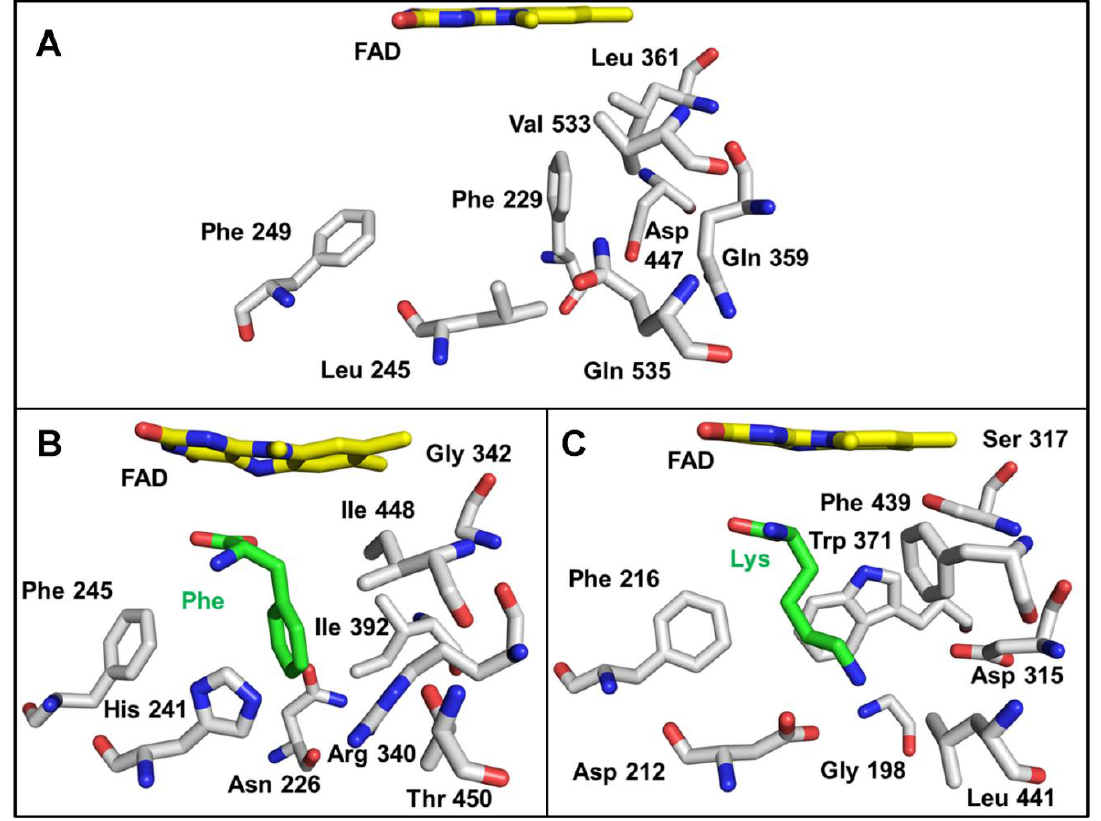
Figure 8. Active site residues that interact with the side chains of the amino acid substrate. In con- trast to Figure 7, the residues in the active site pocket that potentially interact with the substrate side chain are shown. ( A ) P. luteoviolacea CPMOR-1 LAAO. ( B ) SvLAAO from C. rhodostoma (PDB 2IID) with a Phe substrate present. ( C ) TvLAAO (PBD 7C3H) with a Lys substrate present. Oxygens are red, nitrogens are blue, and carbons are grey in the protein amino acids, yellow in FAD and green in the amino acid substrates.